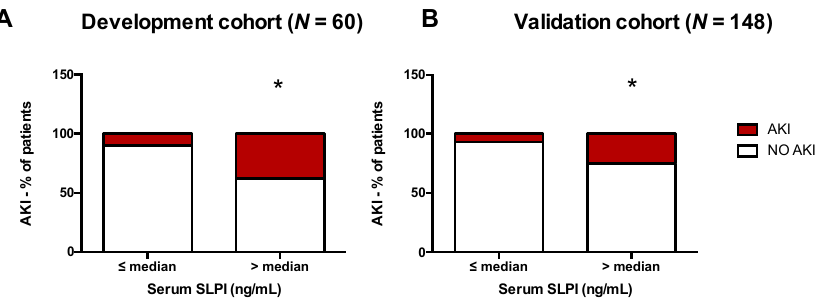
Figure 3. Percentage of patients with AKI within 72 h after cardiac surgery, stratified by median serum SLPI concentration 24 h after surgery ( A ) in the development cohort and ( B ) validation cohort. AKI, acute kidney injury; SLPI, secretory leukocyte protease inhibitor. * p < 0.05 analyzed by Fisher’s exact test.